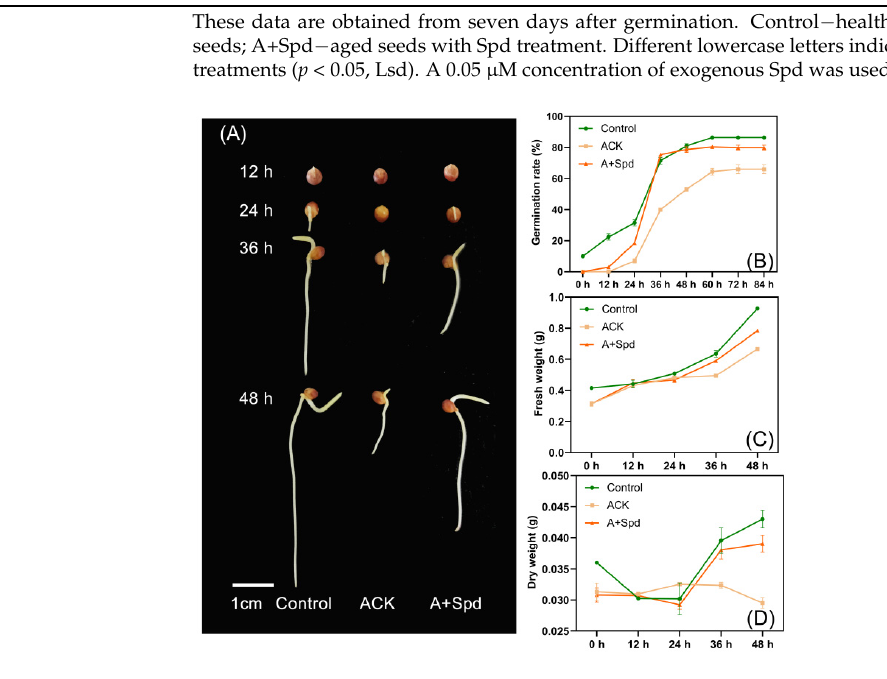
Figure 1. Exogenous Spd enhances germination of aged sorghum seeds. ( A ) germination pheno- types of sorghum seeds for 12–48 h with different treatments (Control, healthy seed; ACK, artifi- cially aged seed; A+Spd, aged seeds with Spd treatment). Scale bar = 1 cm. ( B ) Quantitative analysis of the final germination rate of the different treatments in ( A ). ( C ) Quantitative analysis of fresh weight from 0–48 h of germination of different treatments in ( A ). ( D ) Quantitative analysis of dry weight from 0–48 h of germination of different treatments in ( A ). A 0.05 µ M concentration of exogenous Spd was used.